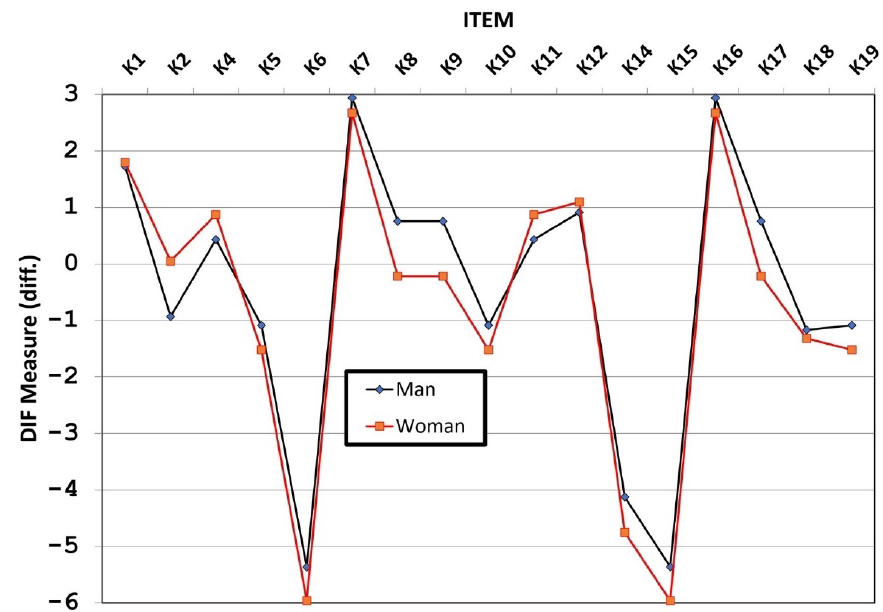
Figure 4. Differential item functioning based on sex.